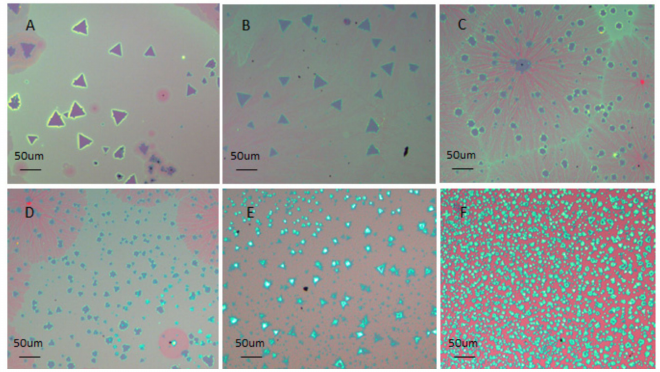
Figure 3. The optical images of the MoS 2 flakes grown on Mn/SiO 2 /Si substrate with different temperatures: ( A ) 855 ◦ C, ( B ) 837 ◦ C, ( C ) 828 ◦ C, ( D ) 812 ◦ C, ( E ) 749 ◦ C, and ( F ) 730 ◦